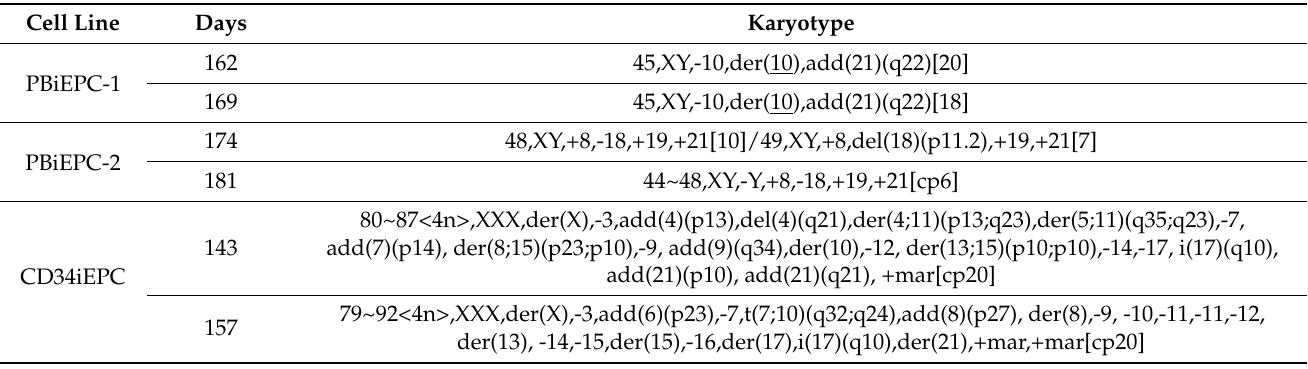
Table 1. Karyotypes of the iEPCs on different days of